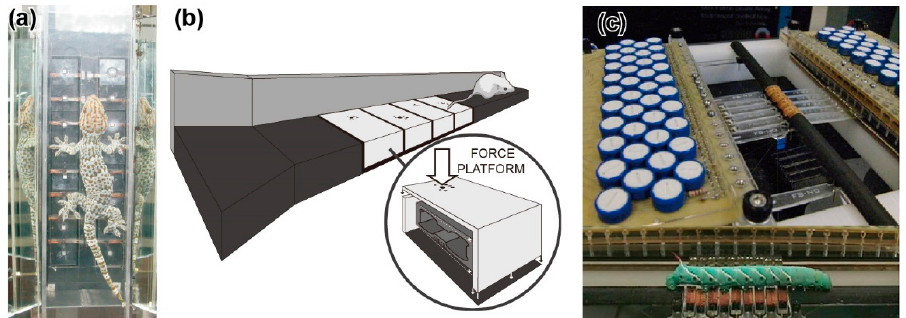
Figure 4. Photographs and schematic image of force plate arrays for a small animal. ( a ) Climbing gecko on a force plate array. Reprinted/adapted with permission from [79]. 2022, Company of Biologists ltd. ( b ) Force plate array for a running mouse. Reprinted/adapted with permission from [81]. 2022, Elsevier. ( c ) Cantilever-type force plate array for a caterpillar. Reprinted/adapted with permission from [86]. 2022, Elsevier.